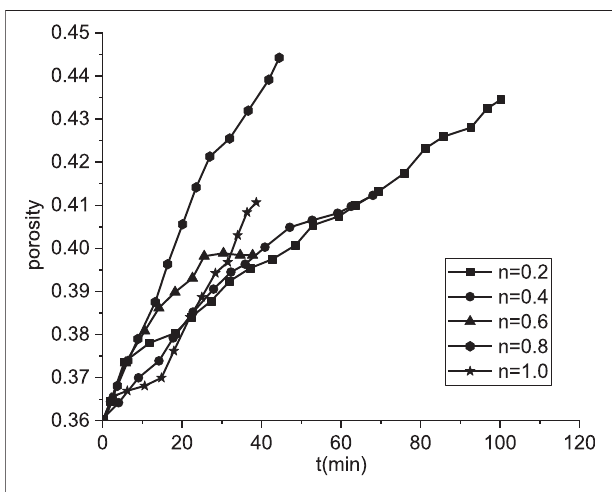
FIGURE 5 | Time-varying curve of porosity with different particle size